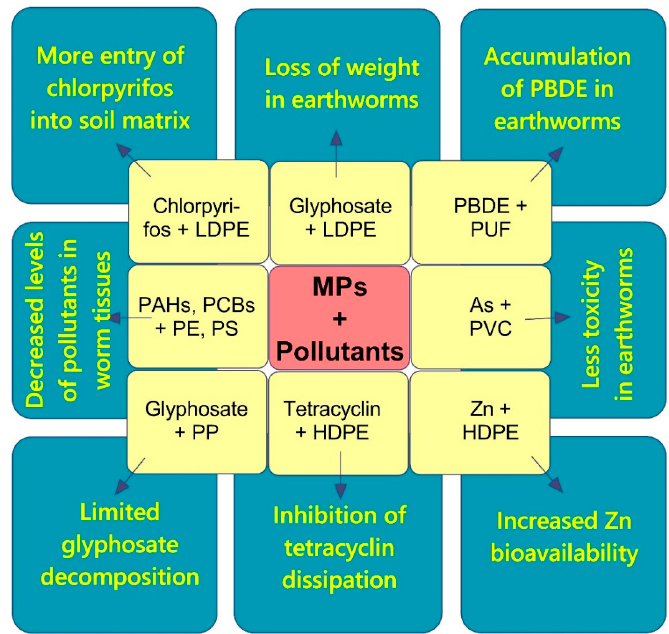
Figure 5. Impact of MPs in the presence of other environmental pollutants in soil [226]. LDPE— Low ‐ density polyethylene, PBDE—Polybrominated diphenyl ethers, PUF—Polyurethane foam, PAHs—Polycyclic aromatic hydrocarbons, PCBs—Polychlorinated biphenyls, PE—Polyethene, PS—Polystyrene, PVC—Polyvinyl chloride, PP—Polypropylene, HDPE—High ‐ density polyethylene.